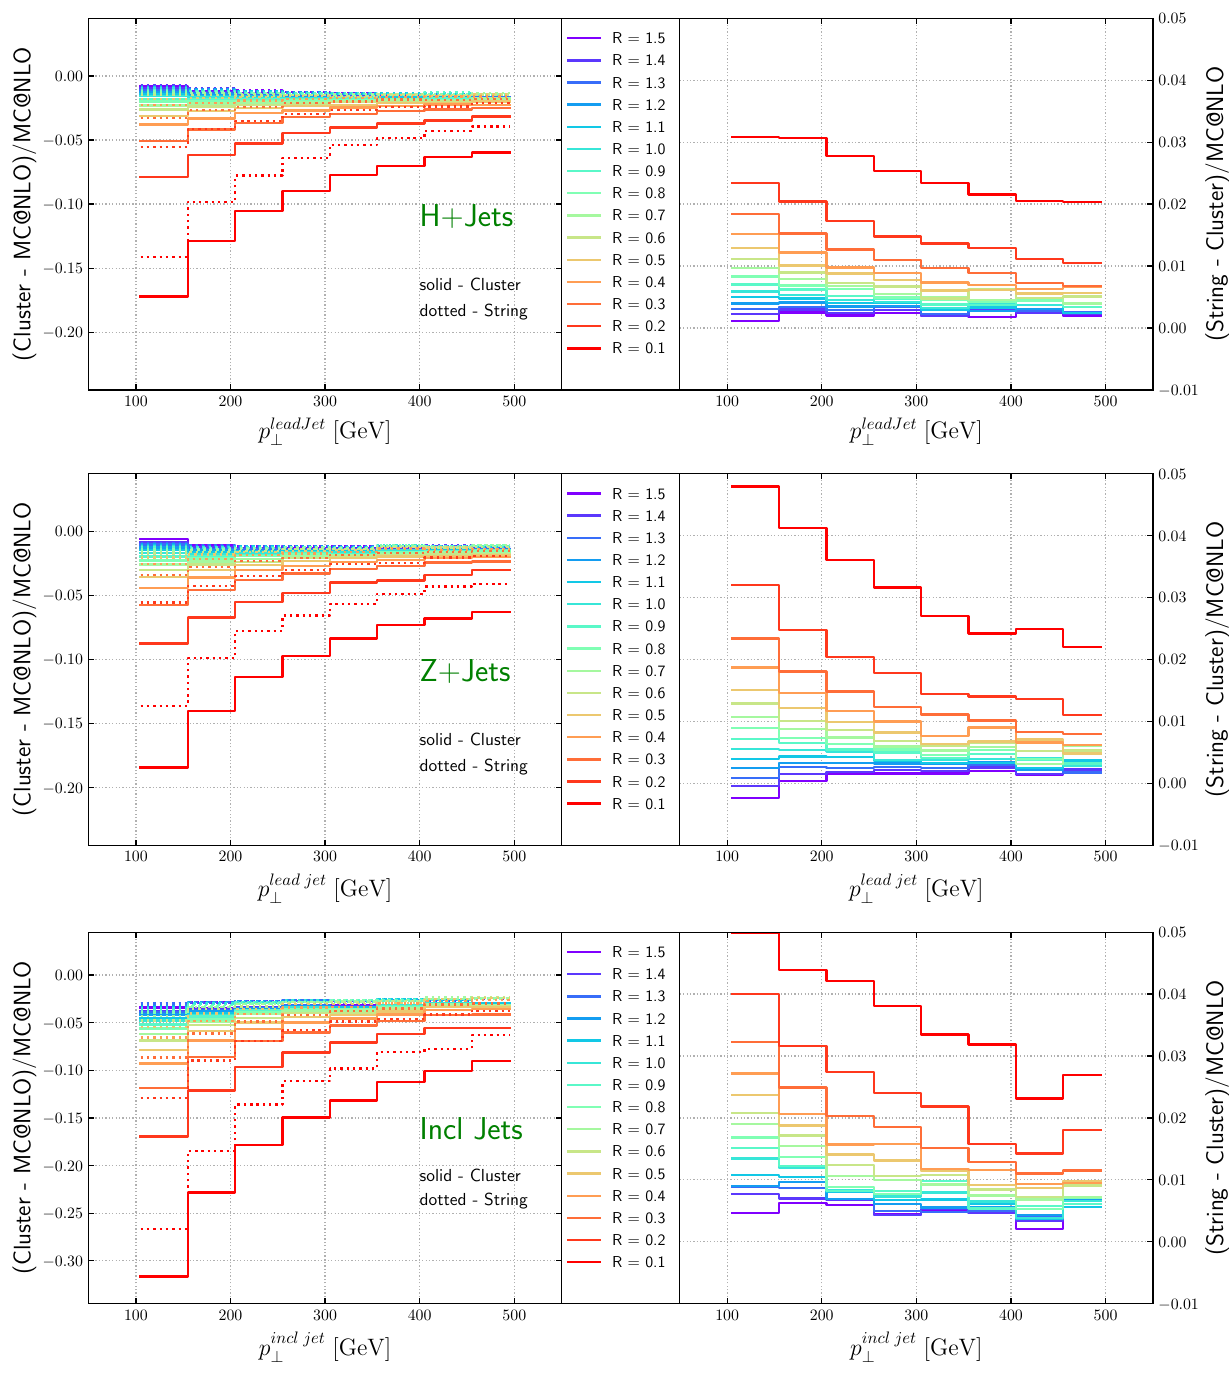
Fig. 18 Hadronization corrections and uncertainties for Higgs + jets (top), Z + jets (middle) and inclusive jets (bottom)